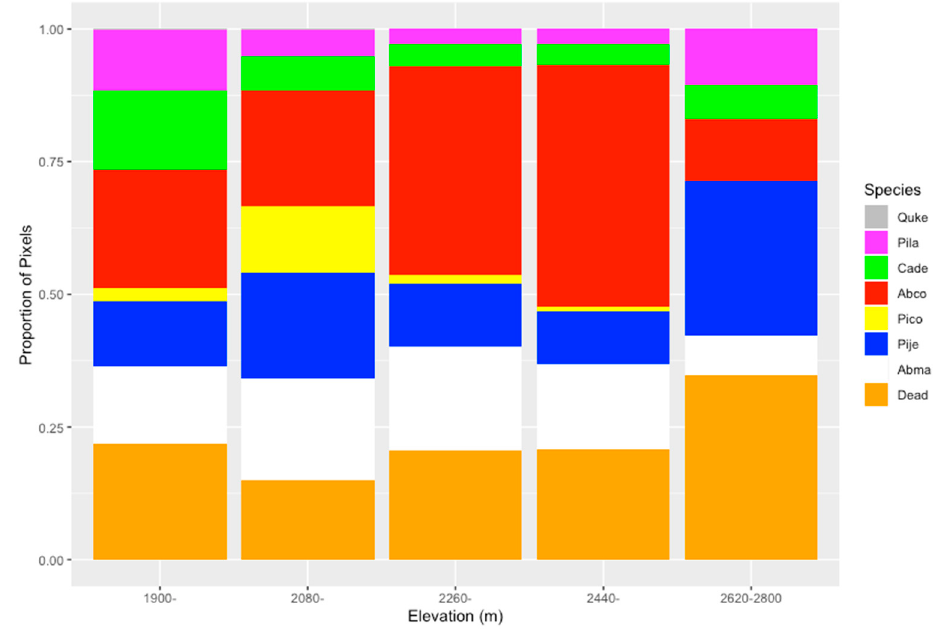
Figure 5. The proportion of pixels classified as each species within elevation bands along the elevation gradient for the seven mapped species and dead canopies.